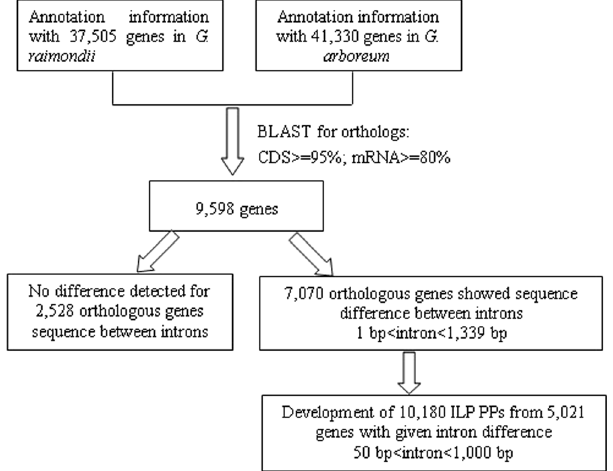
Figure 7. The development scheme of genome-wide ILP markers in this